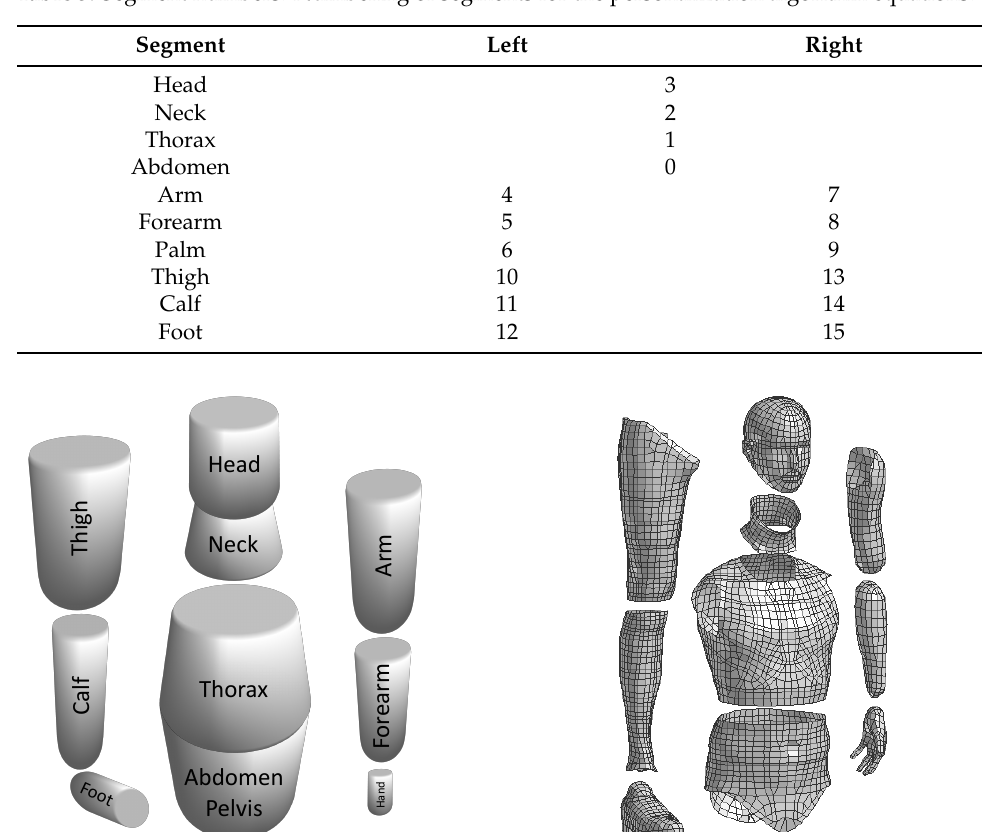
Table 3. Segment numbers. Numbering of segments for the personalization algorithm equations.